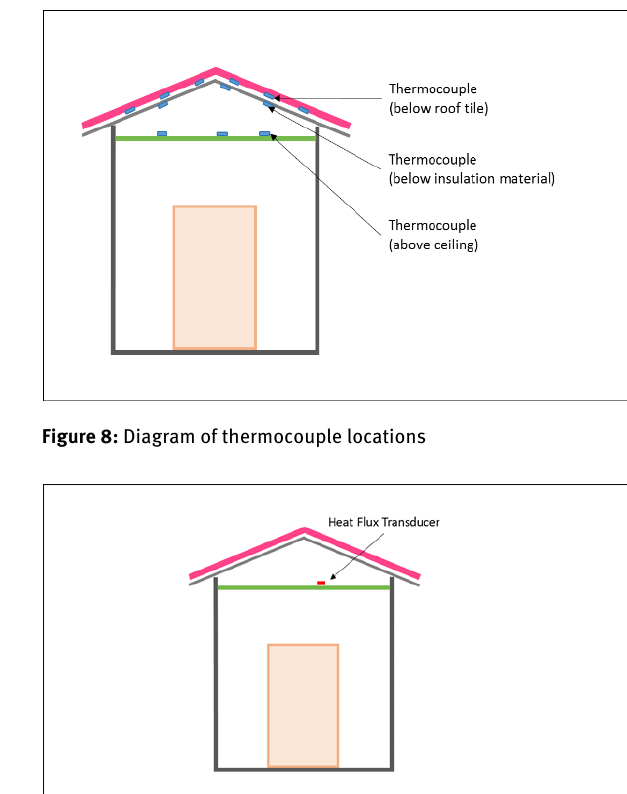
whereby Test Hut 2 was without any insulation material underneath the roof.